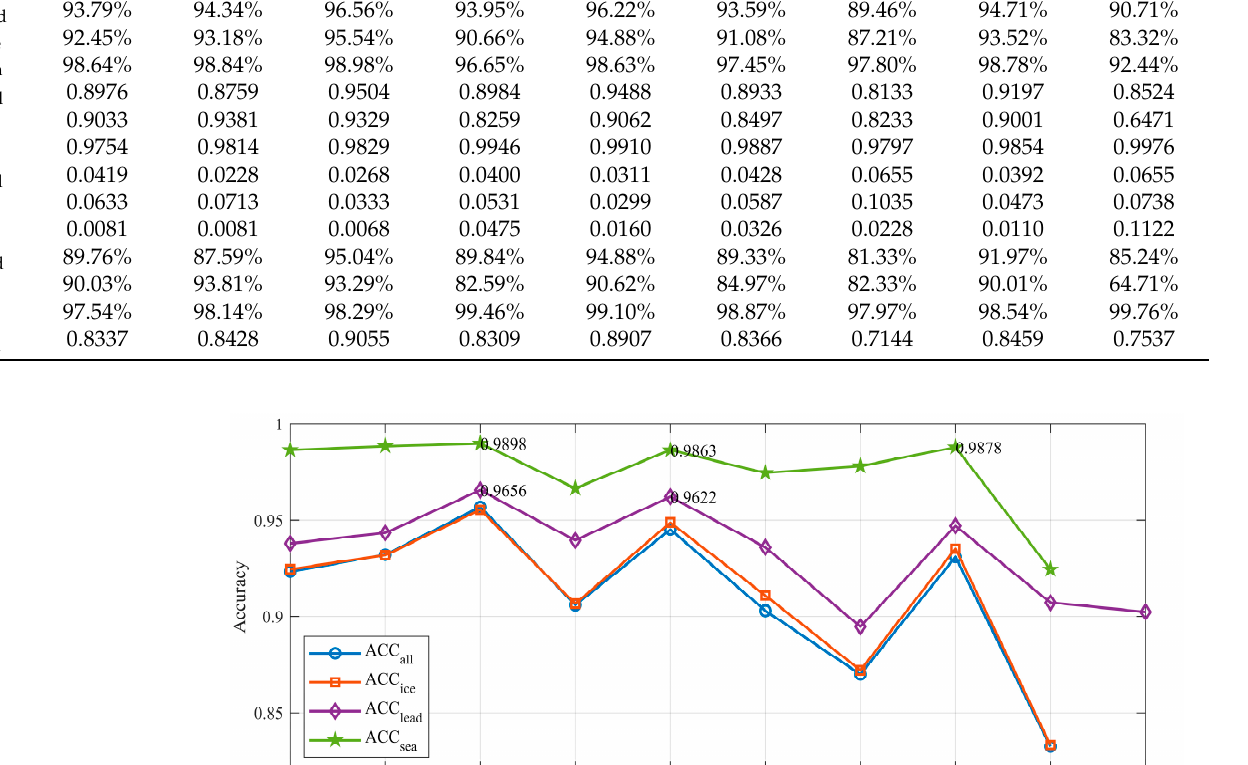
Figure 10. ROC curve and AUC of supervised classifier: ( a ) lead; ( b ) sea ice.